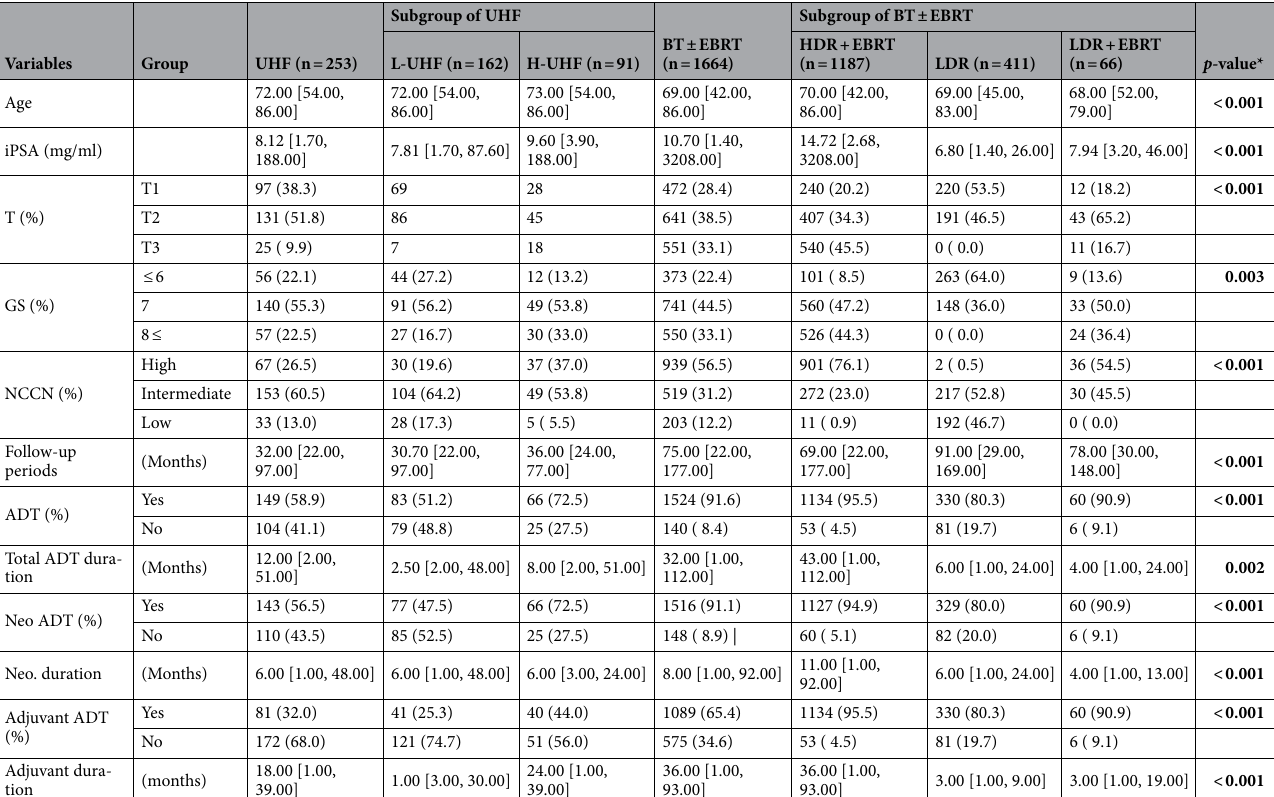
Table 1. Patients characteristics between ultrahypo fractionated radiotherapy and brachytherapy with or without external beam radiotherapy. Bold values indicate statistically significance. *p-value was calculated between UHF and BT ± EBRT. BT brachytherapy, EBRT external beam radiotherapy, UHF ultrahypofractionated radiotherapy, L-UHF low dose UHF EQD2 < 100 Gy1.5 (α/β = 1.5), H-UHF high dose UHF EQD2 ≥ 100 Gy1.5 (α/β =